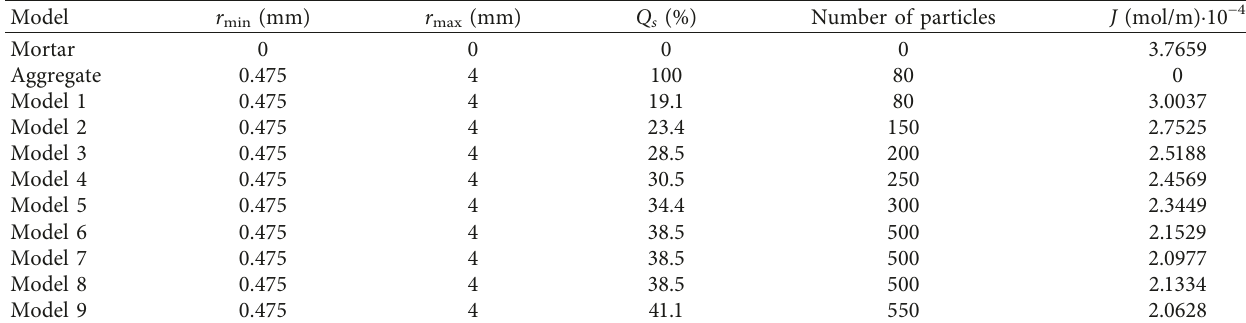
Table 2: Parameters of random concrete aggregate